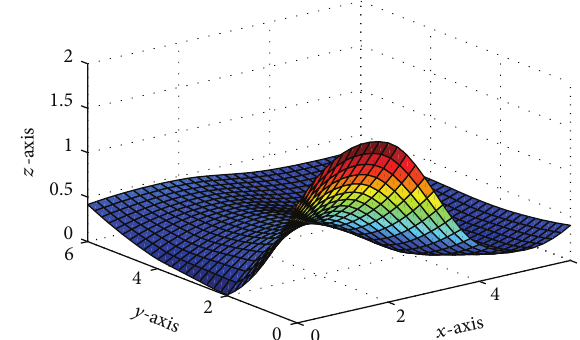
Figure 4: Positivity preserving by using our partially rational bicubic